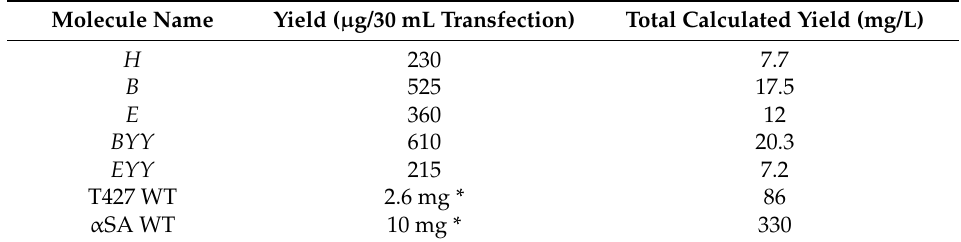
Table 4. Calculated production yields of all bsAbs produced in Expi293™ mammalian